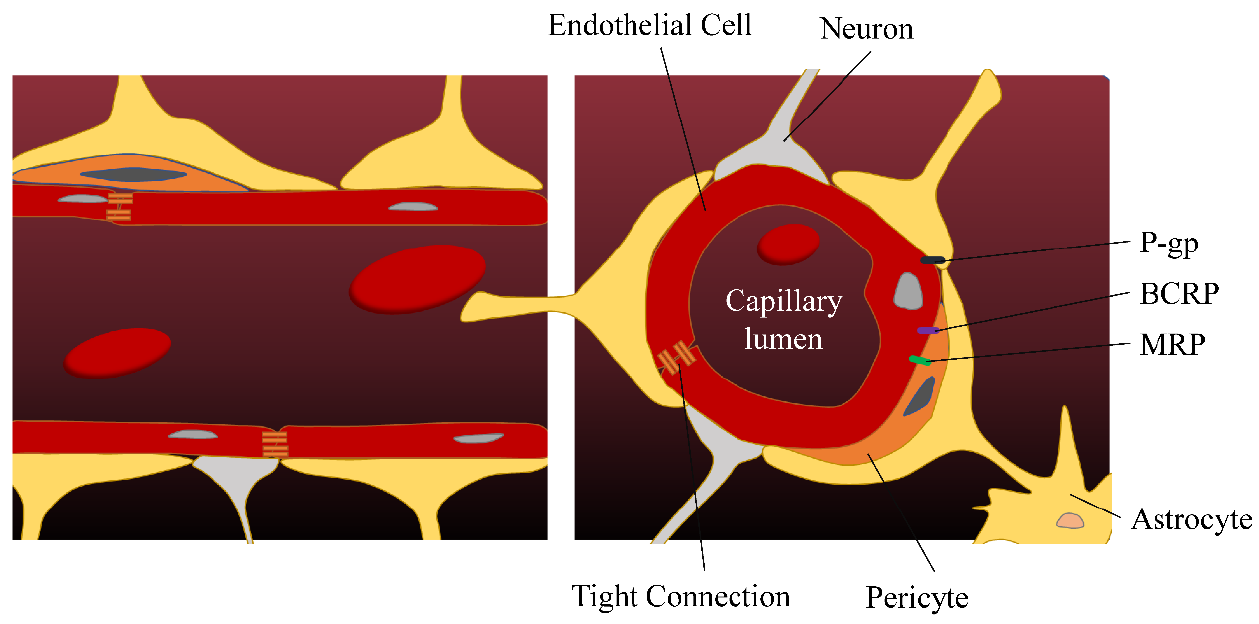
Figure 1. The blood–brain barrier. P-gp, P-glycoprotein; BCRP, breast cancer resistance protein; MRP, Figure 1. The blood – brain barrier. P-gp, P-glycoprotein; BCRP, breast cancer resistance protein; multidrug resistance-associated MRP, multidrug resistance-associated protein.